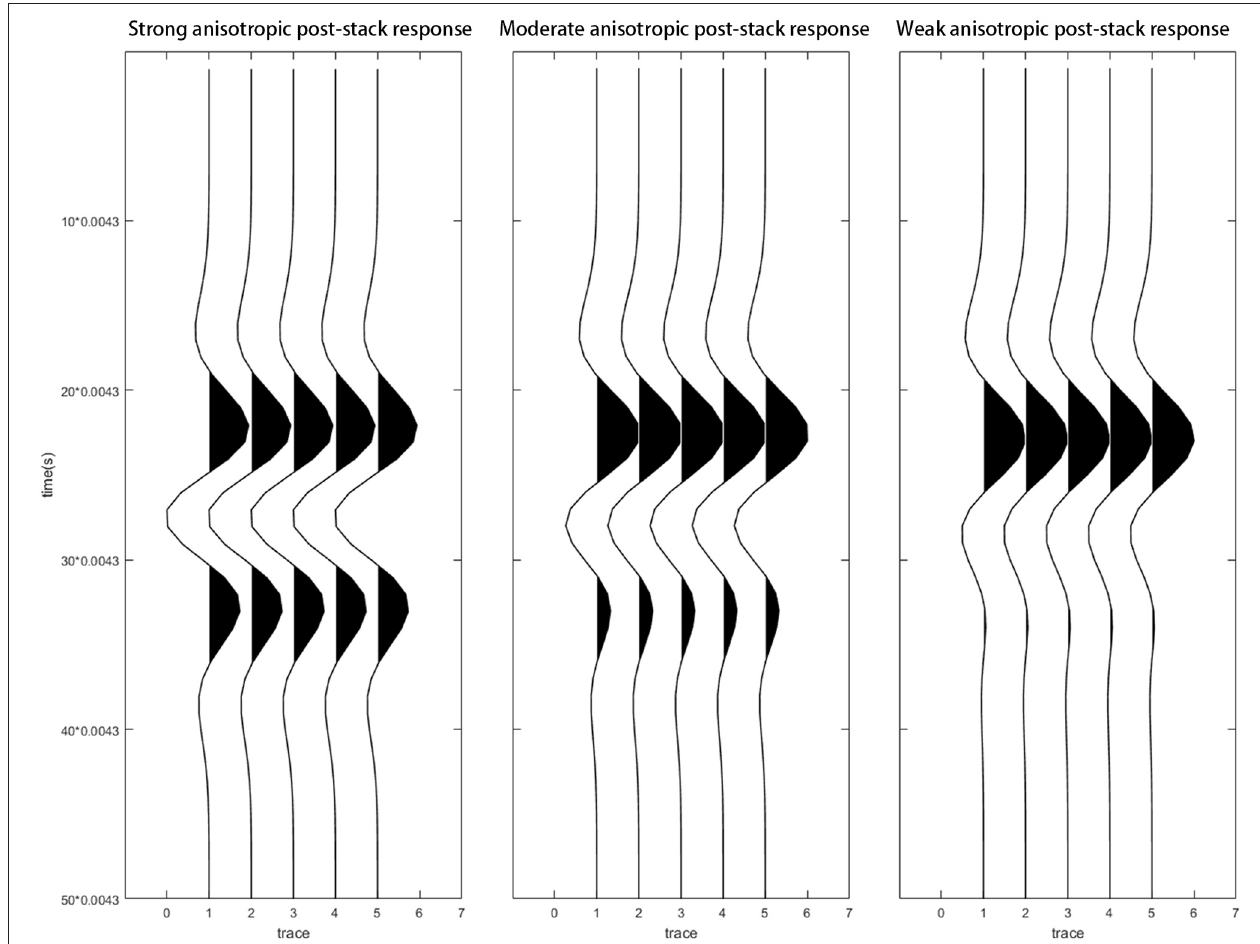
FIGURE 4 | Qualitative model post-stack response.